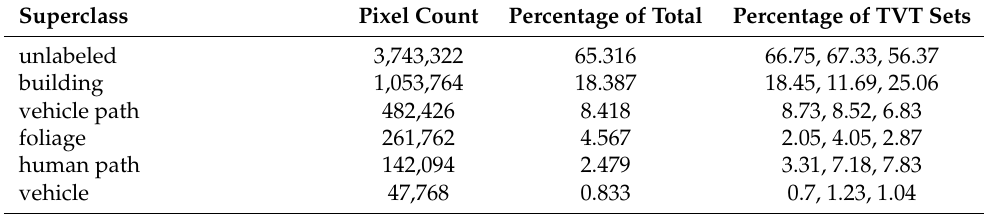
Table A2. Superclass statistics over total imaged area and within training, validation, and test